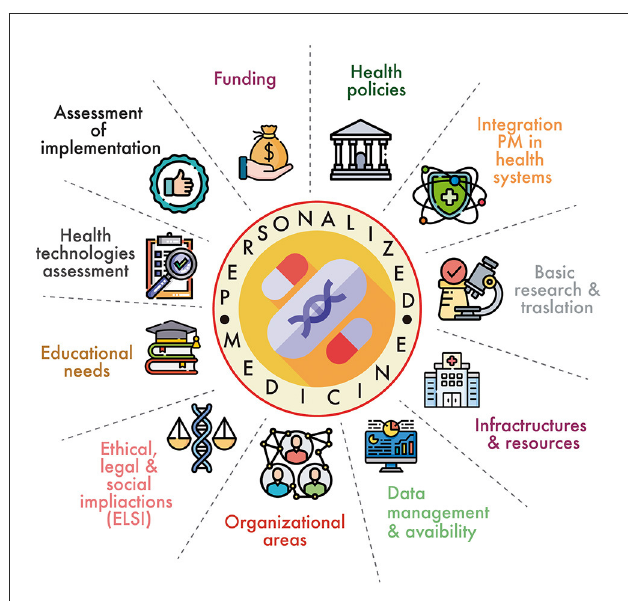
FIGURE2 Graphical representation of framework domains. Source: